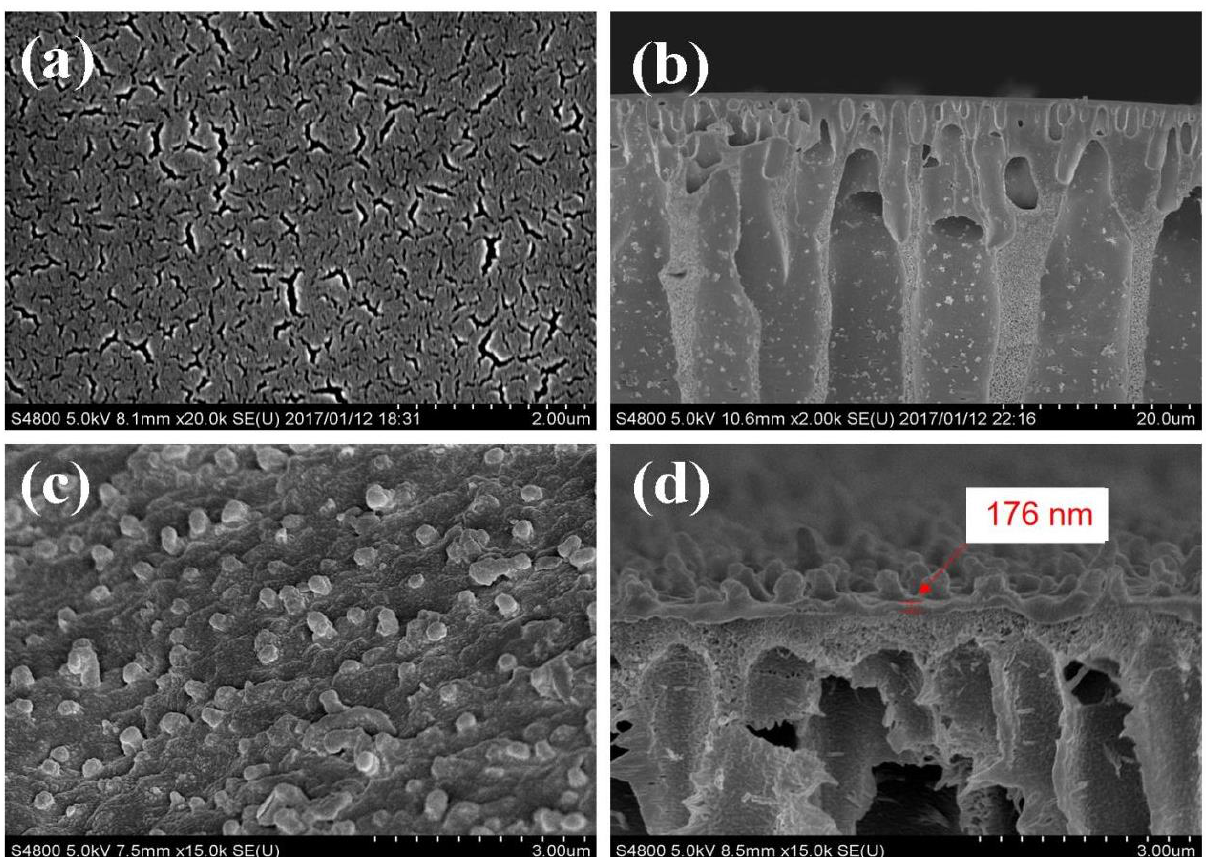
Figure 3. Morphologies of surface ( a , c ) and cross-section ( b , d ) of PMIA hollow fiber substrate membrane and NF membrane, respectively.